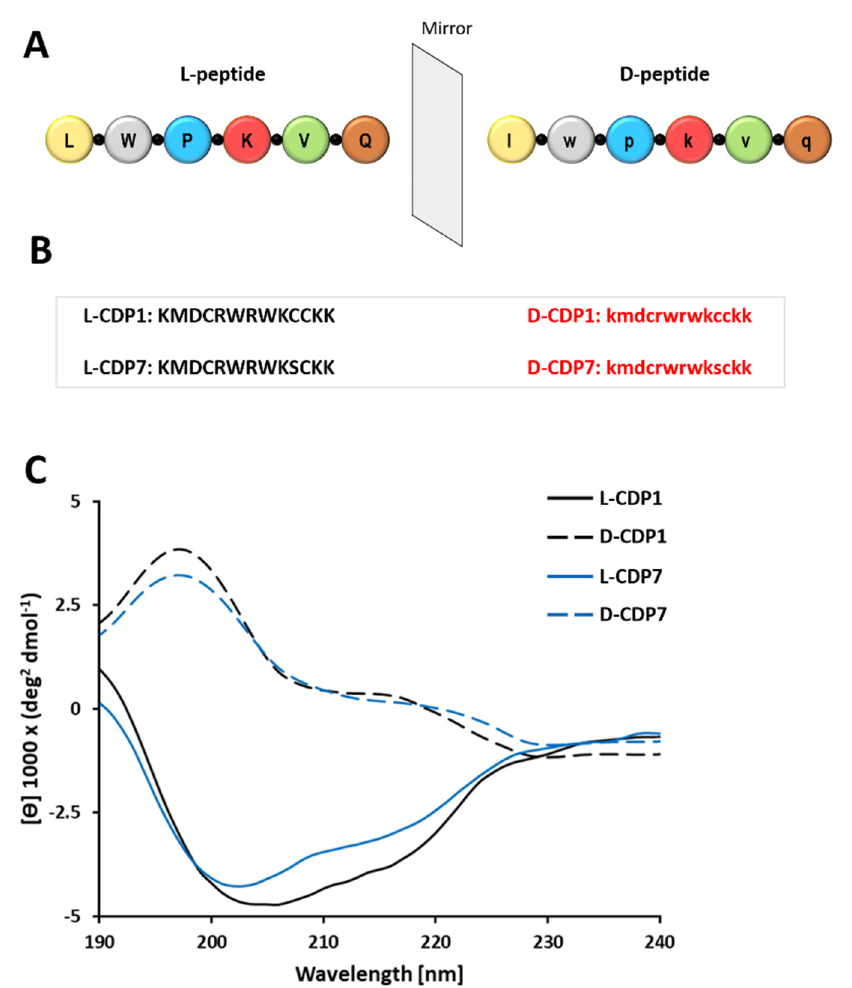
Figure 4. Principle of D-peptides. ( A ): Schematic diagram of D-peptides. ( B ): Sequences of D-CDP1, D-CDP7, and their mother L-peptides. ( C ): Circular dichroism (CD) spectroscopy of L- and D-CDP peptides. The CD spectrum of D-peptide in solution is presented as molar ellipticity [ θ ].